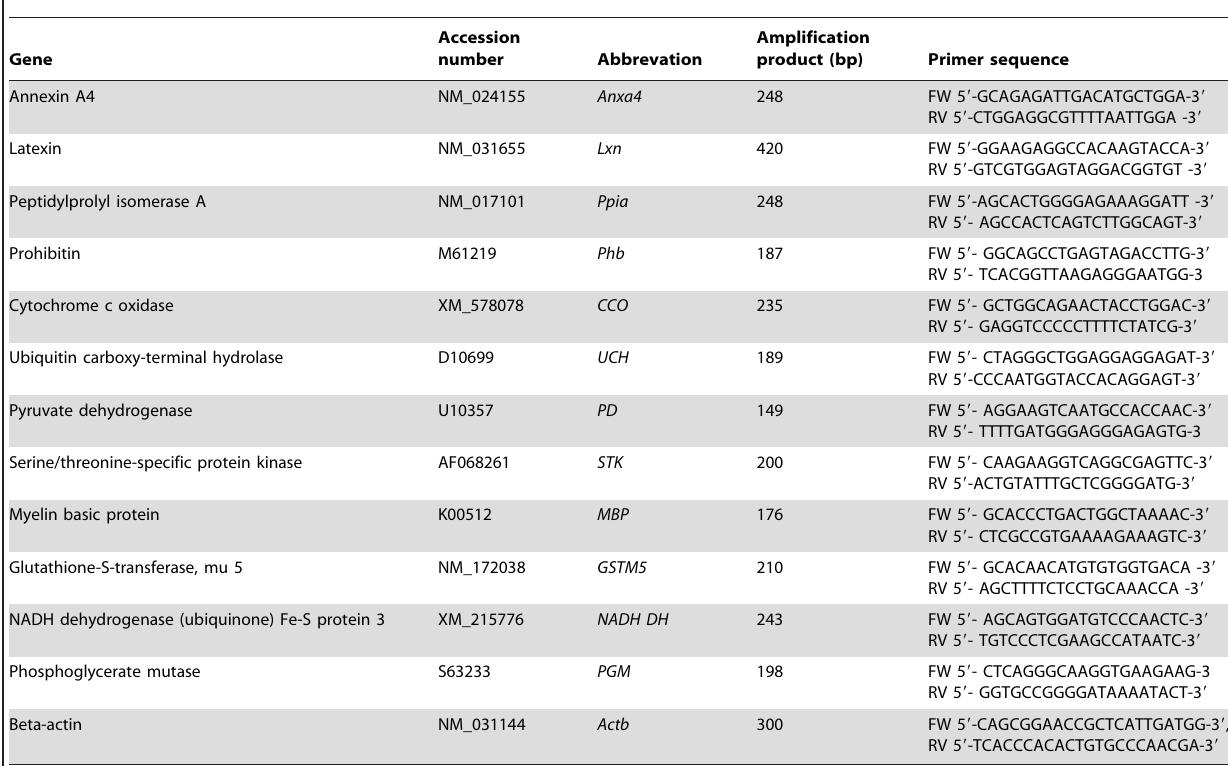
Table 1. Primers used for RT-PCR